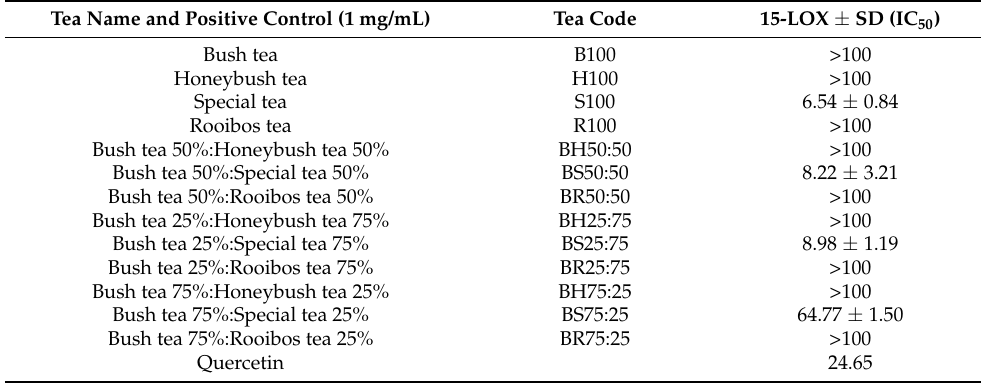
Table 2. Anti-inflammatory activity of selected herbal